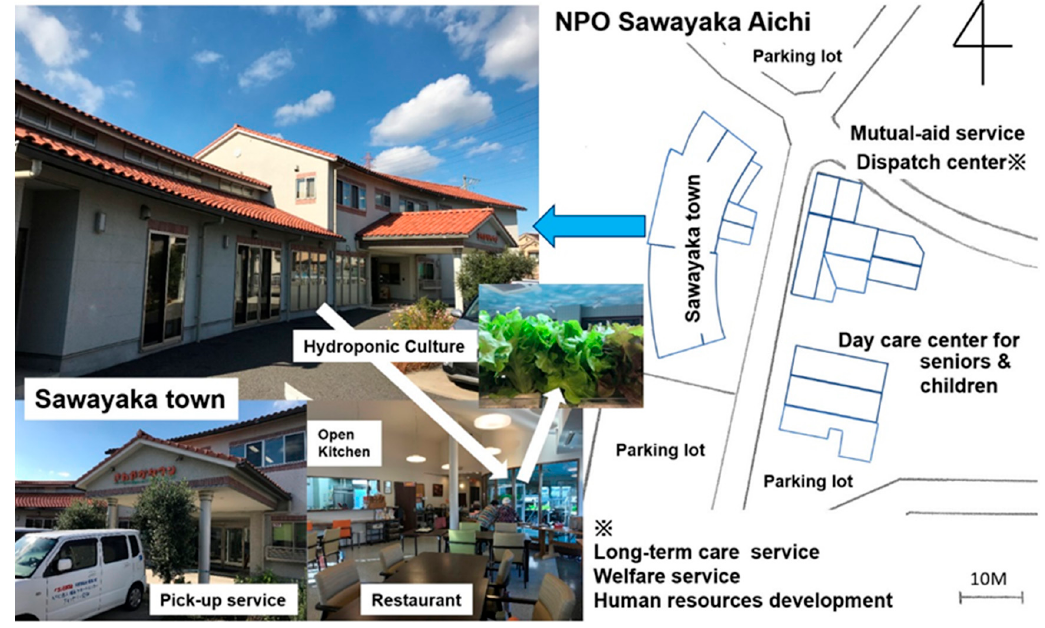
Figure 3. The nonprofit organization (NPO) Sawayaka-Aichi in a Japanese suburb.